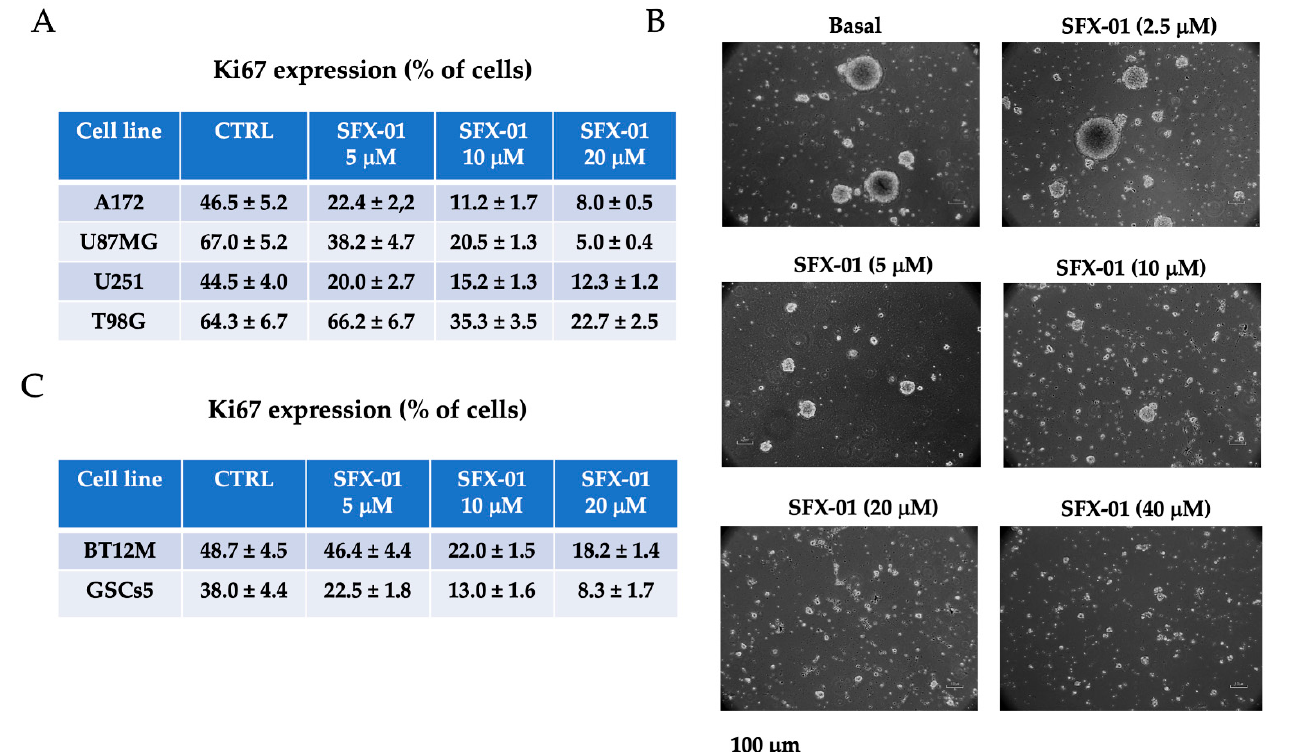
Figure 3. SFX-01 inhibits cell proliferation in GBM cell lines and GICs: ( A ) Ki67-positive cells-percentage of Ki67-positive cells in A172, U87MG, U251, and T98G cell lines treated with 5, 10, and 20 µM SFX-01. ( B ) Sphere formation assay performed on BT12M treated with different doses of SFX-01. Bars represent 50 µm. ( C ) Ki67-positive cells in BT12M and GSC-5 GICs treated with 5, 10, and 20 µM SFX-01.